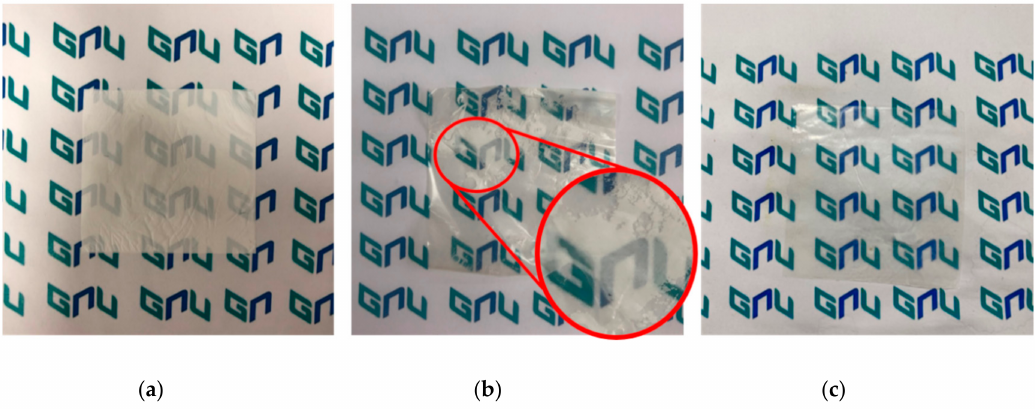
Figure 6. The photo comparison: ( a ) porous polyethylene support, ( b ) crosslinked pore-filling membrane without a cylindrical centrifugal machine, and ( c ) crosslinked pore-filling membrane with the cylindrical centrifugal machine.